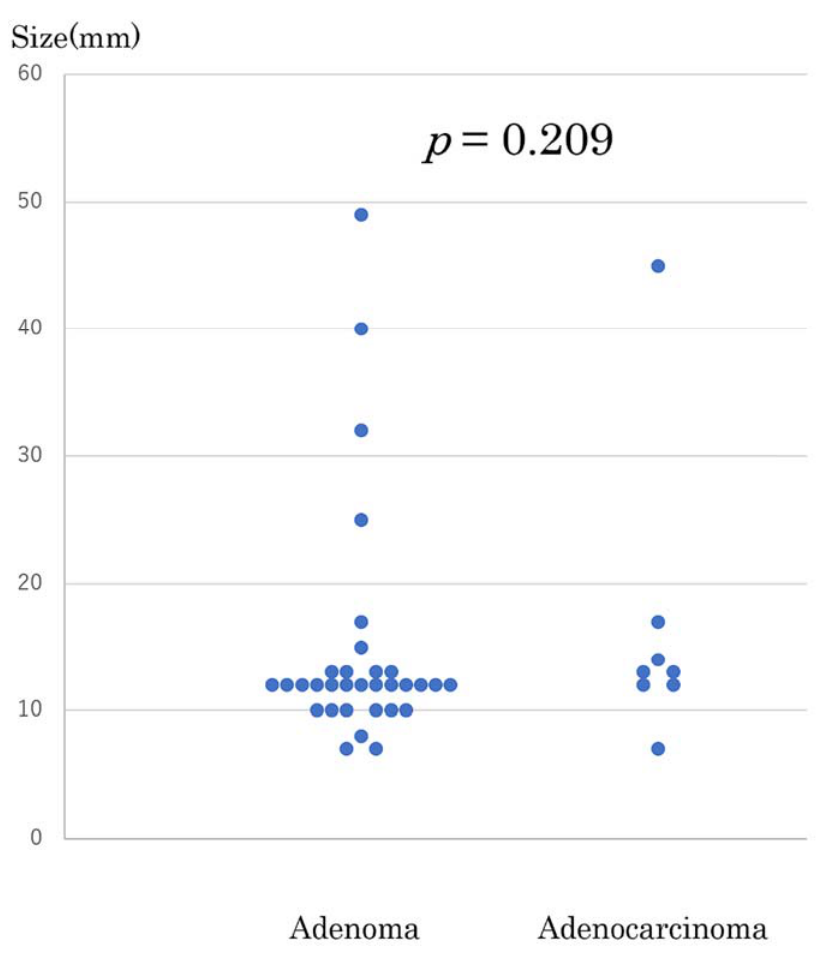
Figure 4. Distribution of tumor sizes according to final diagnoses of adenoma and adenocarcinoma. Adenoma ( left ), Adenocarcinoma ( right ).